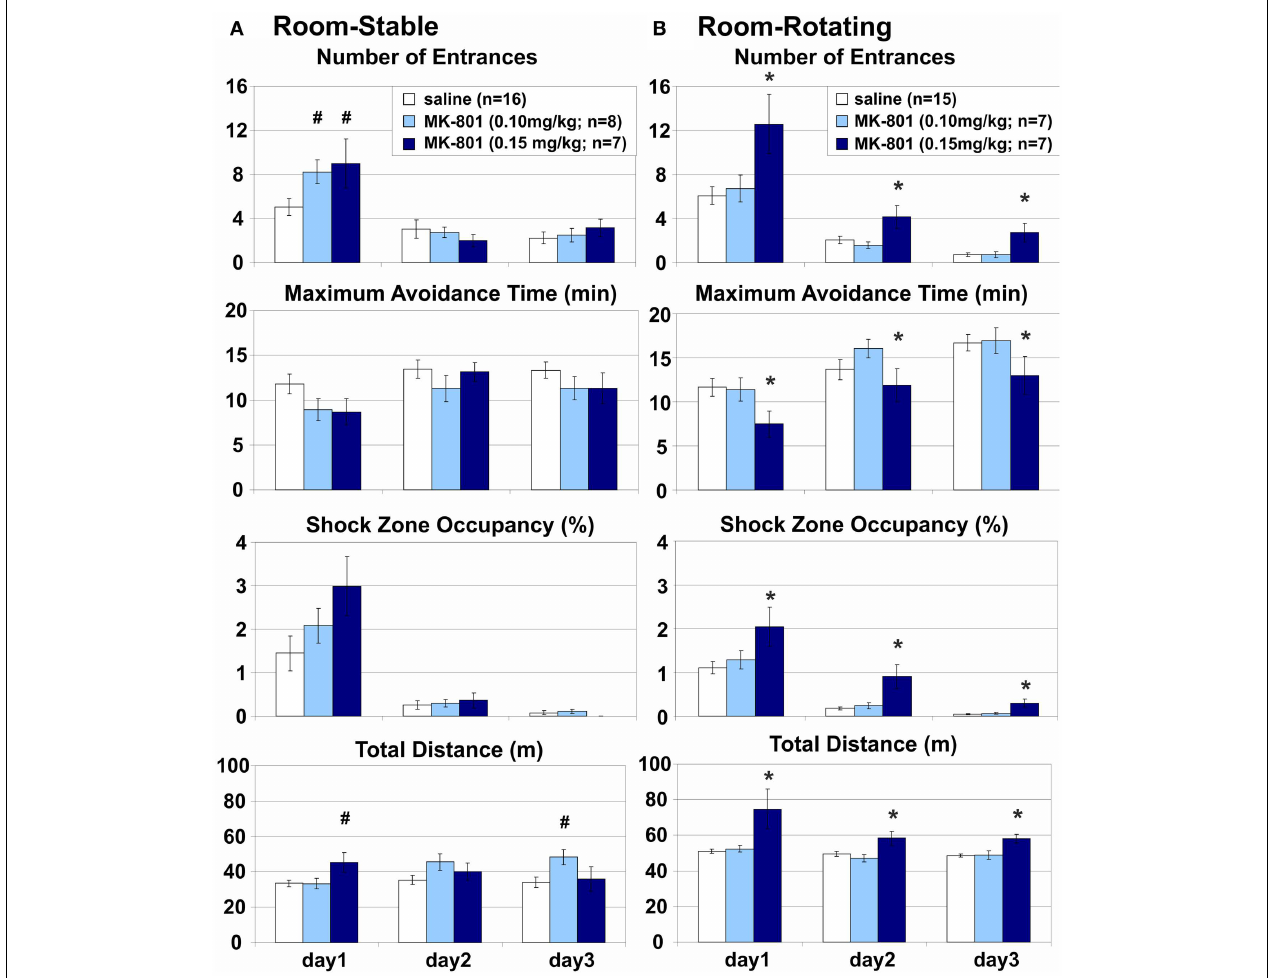
FIGURE 3 | Room-based place avoidance on a Stable and a Rotating arena . (A) Room-Stable place avoidance on a stationary dry arena with no demand for coordination of information from congruent spatial frames. Only a transient increase in the number of Entrances and a similar trend in the Shock Zone Occupancy were observed on day 1 on the Stable arena after either dose of MK-801.This effect was associated with transient hyperlocomotion after the high, but not the low dose of MK-801.